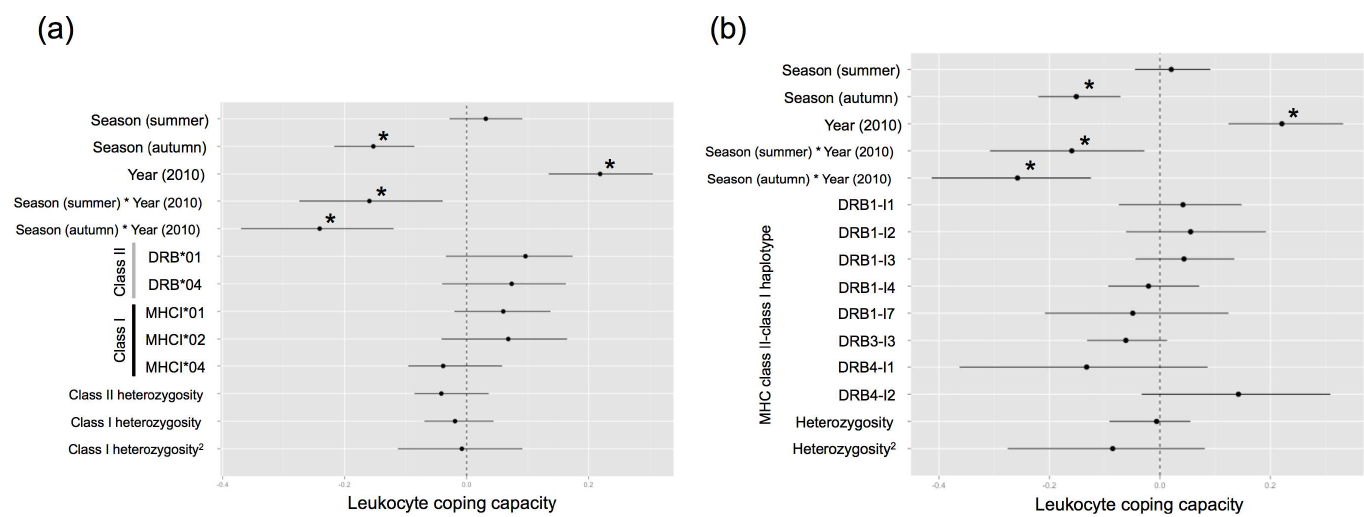
Fig 1. Model averaged parameter estimates and their 95% confidence intervals for the 3 predictors (season, year, season * year), and (a) presence/absence of three MHC class I and two MHC class II genes, linear effect of class II heterozygosity, and linear and quadratic effects of class I heterozygosity, or (b) presence/absence of MHC class II − class I haplotypes, and linear and quadratic effects of haplotypeheterozygosity associated with the leukocyte coping capacity. * indicates a parameter with a significant effect. Spring and year 2009 were the reference